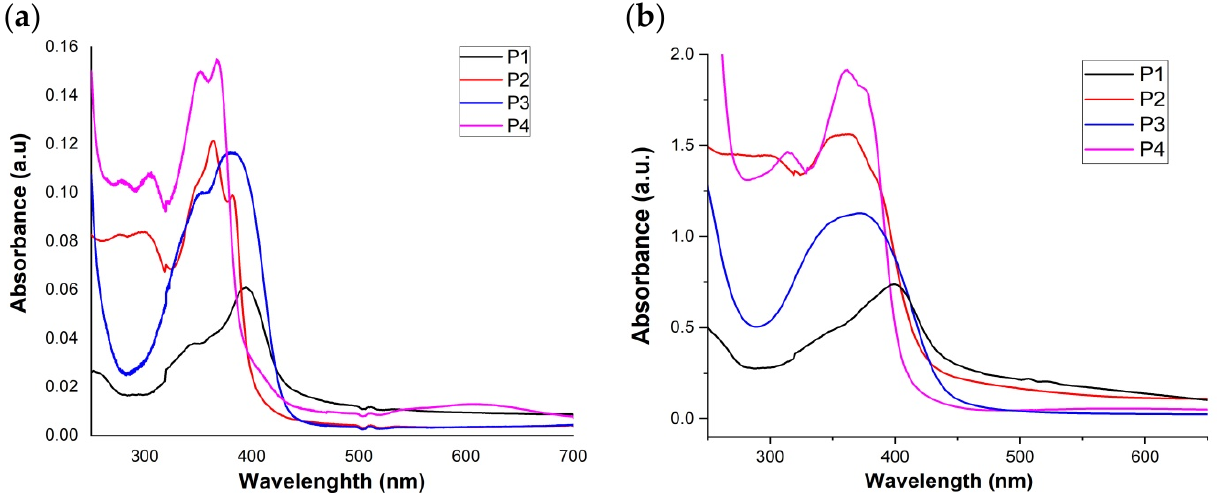
Figure 4. UV–Vis absorption spectra of P1 – P4 in ( a ) CHCl 3 solution and ( b ) thin films cast from CHCl 3 solution.